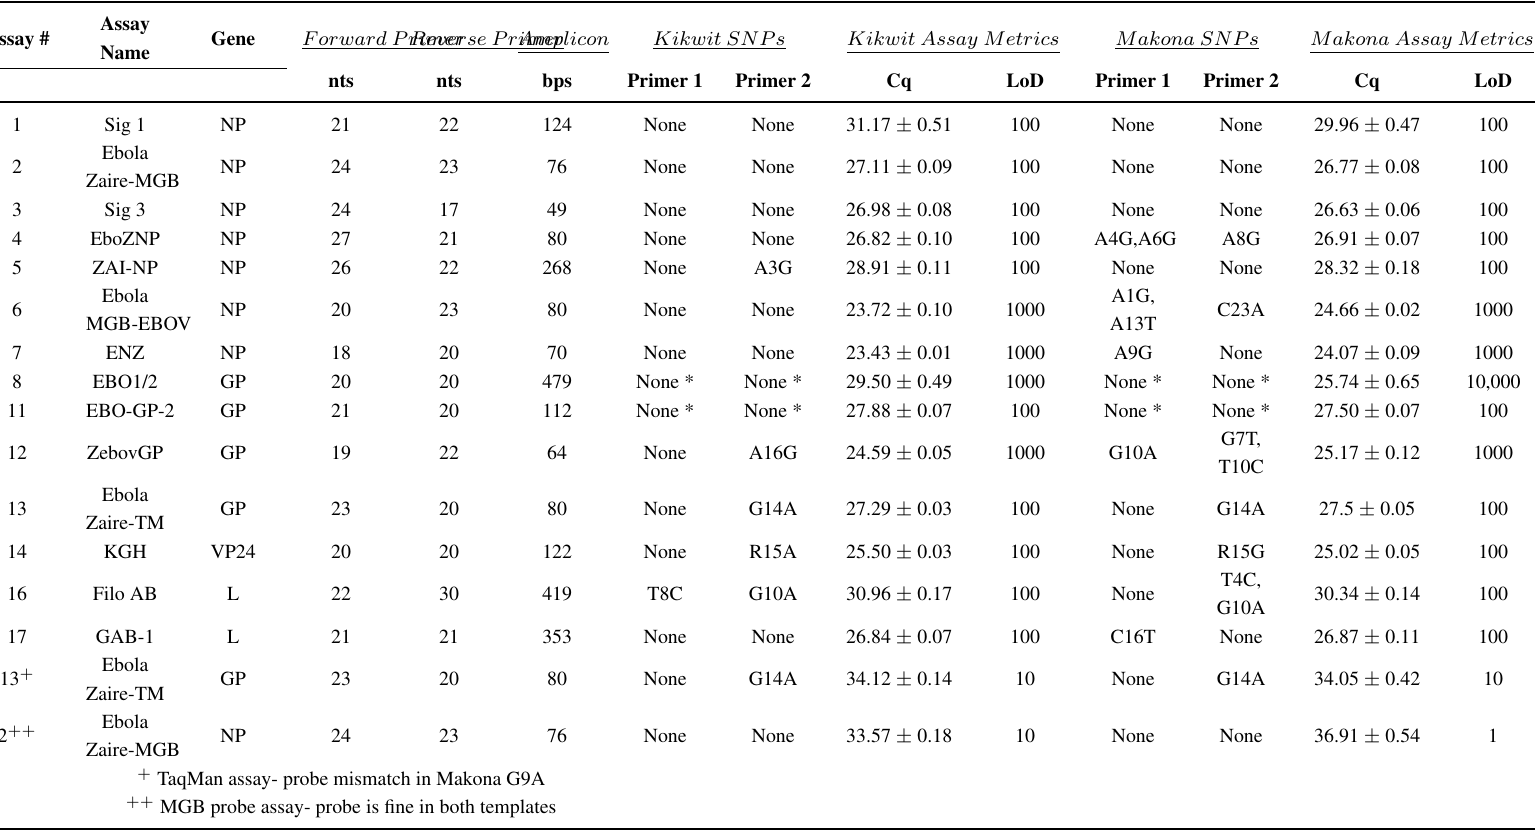
Table 2. SYBR GREEN qRT-PCR results of EBOV Assays (all except the last two are SYBR green